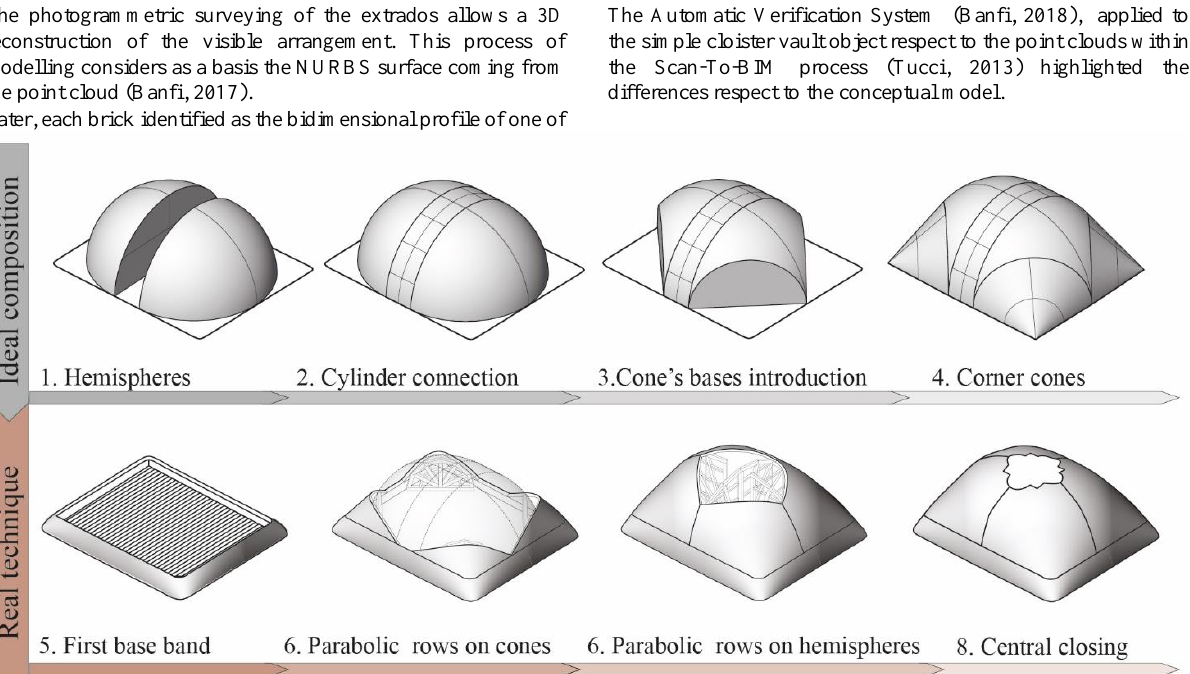
Figure 11. Workflow of geometric analysis of the vault: ideal geometric composition compared to real construction phases.